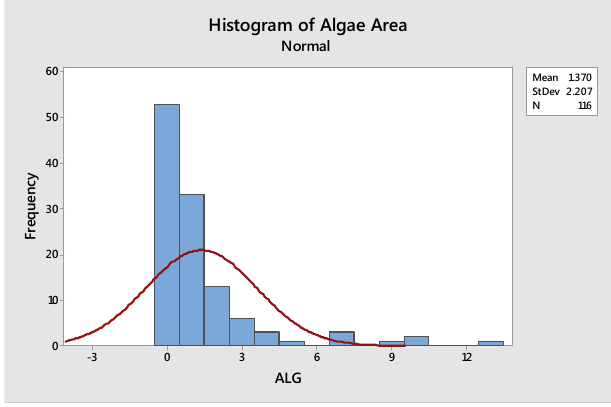
Table 4. Statistics of Algae Area. Figure 3. Histogram of Algae Area. Figure 3. Histogram of Algae Area.